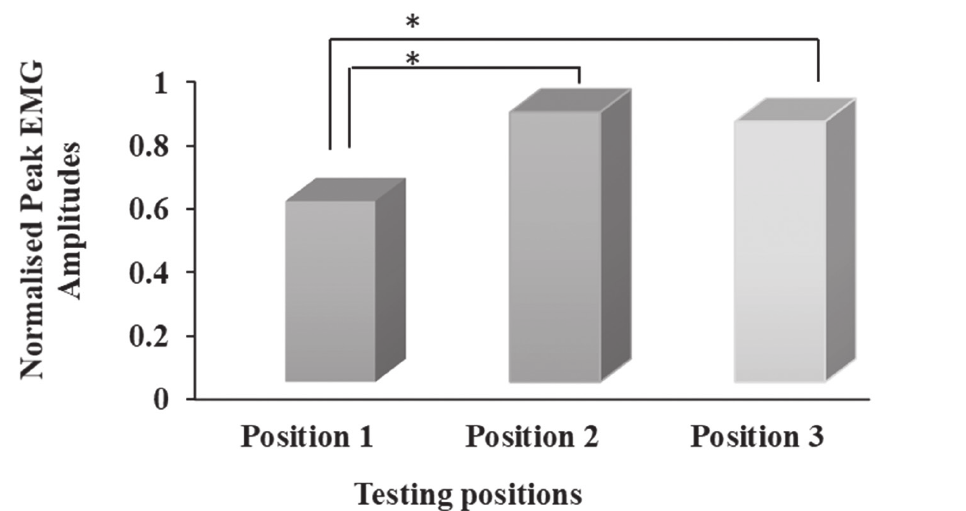
FIGURE 2. Comparison of normalized peak EMG amplitudes of adductor magnus during fully extended hip and knee (Position 1), hip-flexed 45° and knee at 90° (Position 2), and prone hip extension with 90° knee flexion (Position 3)